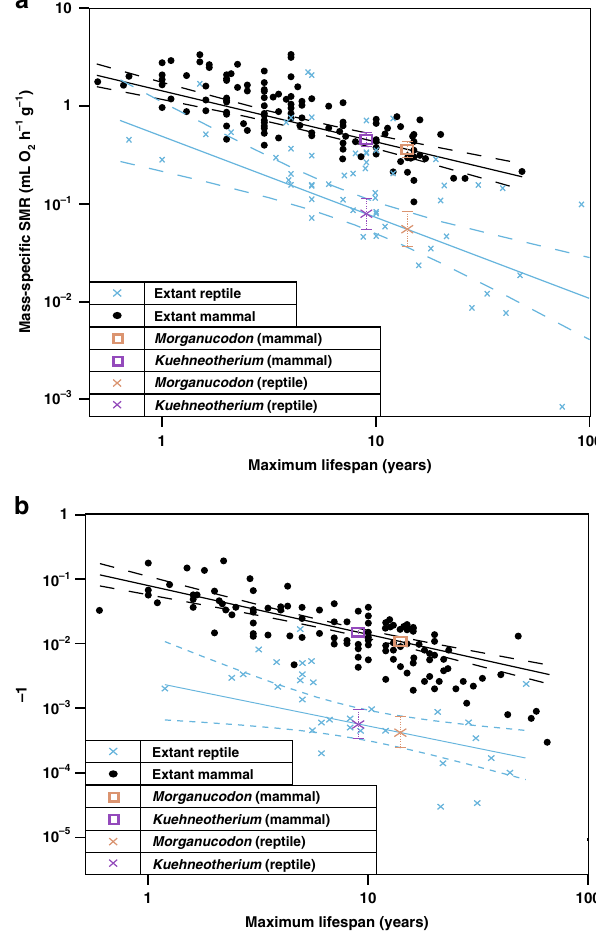
Fig. 5 Lifespan and metabolic estimates of Morganucodon and Kuehneotherium . a Histogram of lifespan estimates from cementum increment counts. b Log 10 phylogenetic least squares (PGLS) biplot of mean body mass (g) against maximum wild lifespan (years) for extant mammals ( n = 279), extant non-avian reptiles ( n = 252) and fossil mammaliaforms. c Log 10 PGLS biplot of mean body mass (g) against mass-speci fi c standard metabolic rate (msSMR; mL O 2 h − 1 g − 1 ) for extant mammals ( n = 117) and extant reptiles ( n = 55) and estimates for fossil mammaliaforms. d Log 10 PGLS biplot of mean body mass (g) against postnatal growth rate constant K (days − 1 ) for extant mammals ( n = 115) and extant reptiles ( n = 33) and estimates for fossil mammaliaforms. PGLS regression lines in b – d are shown for extant mammals (black) and extant reptiles (blue), 95% con fi dence intervals are represented by dashed lines and 95% predictor intervals by dotted lines. Source data are provided as a Source data fi le.